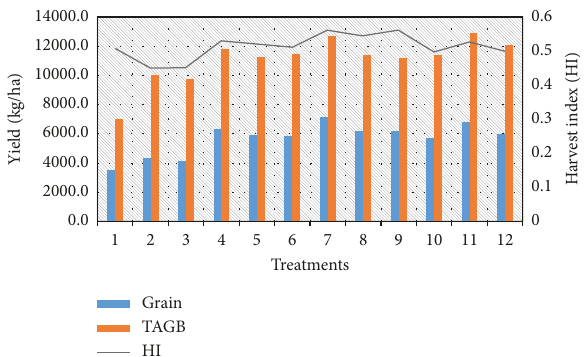
Figure 5: Effect of combined TSP and Tithonia biomass application on grain yield, total aboveground biomass, and HI of maize. Note: 1 � control; 2 � N (full dose); 3 � P (full dose); 4 � NP (recom- mended rate); 5 � 70% P (TSP)+30% P ( Tithonia ); 6 � 60% P (TSP)+40% P ( Tithonia ); 7 � 50% P (TSP)+50% P ( Tithonia ); 8 � 40% P (TSP)+60% P ( Tithonia ); 9 � 30% P (TSP) +70% P ( Tithonia ); 10 � 20% P (TSP)+80% P ( Tithonia ); 11 � 10% P (TSP)+90% P ( Tithonia ); 12 � Tithonia alone (100%